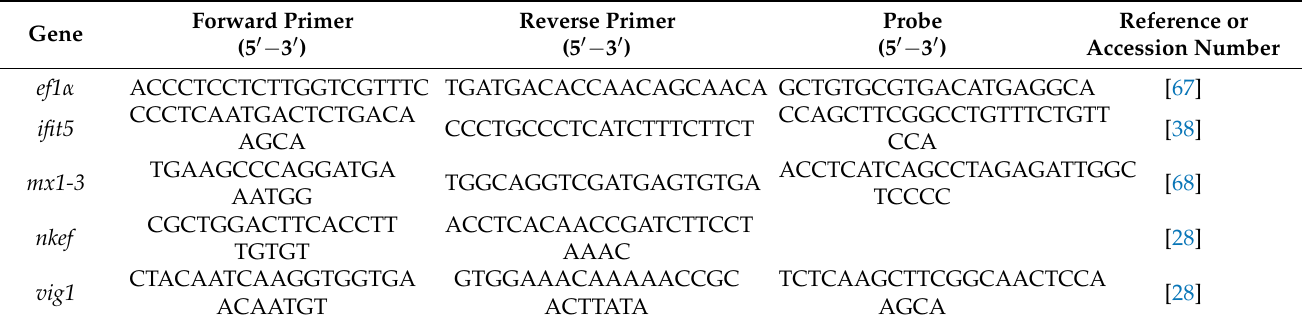
Table 3. Primers and probes sequences used in quantitative